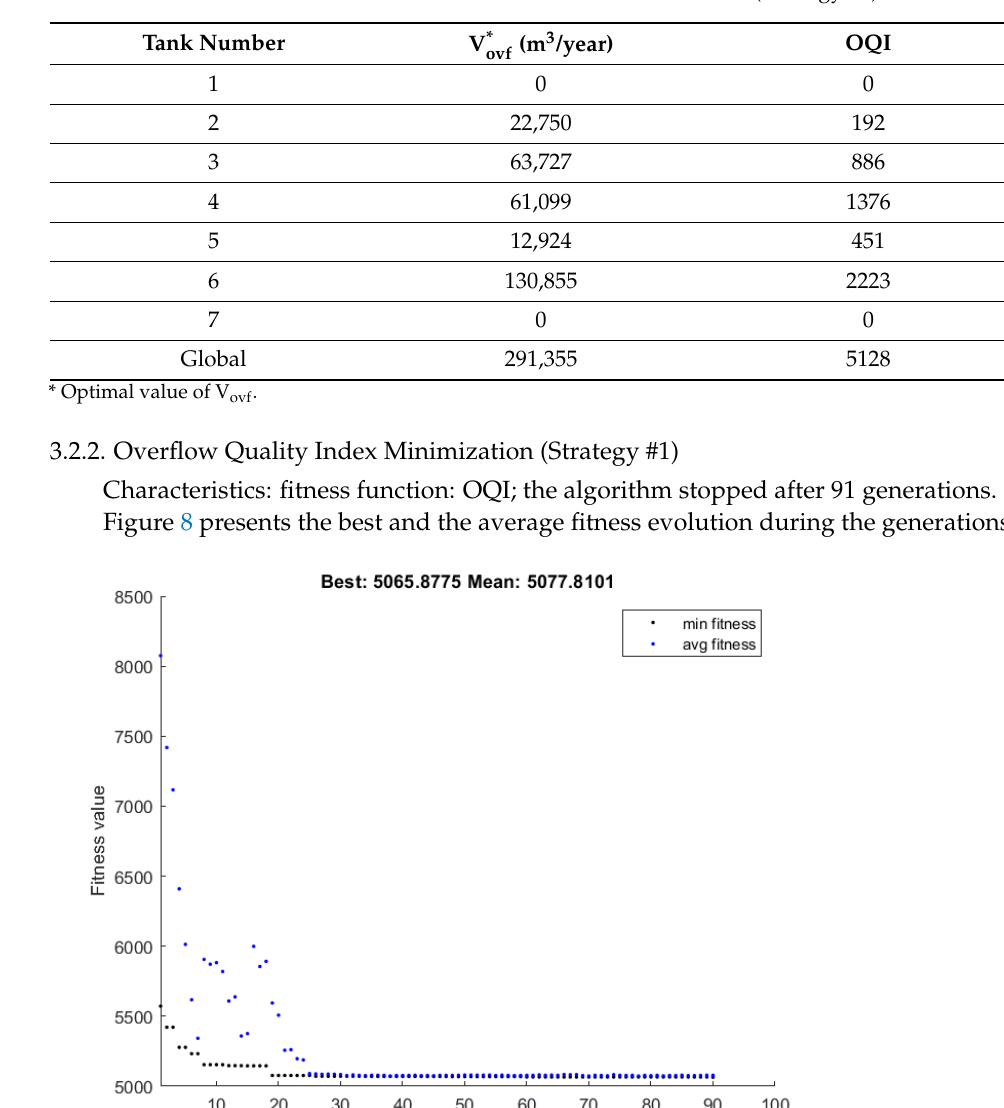
Table 8. Simulation results when the overflow quality index is minimized (strategy #1).